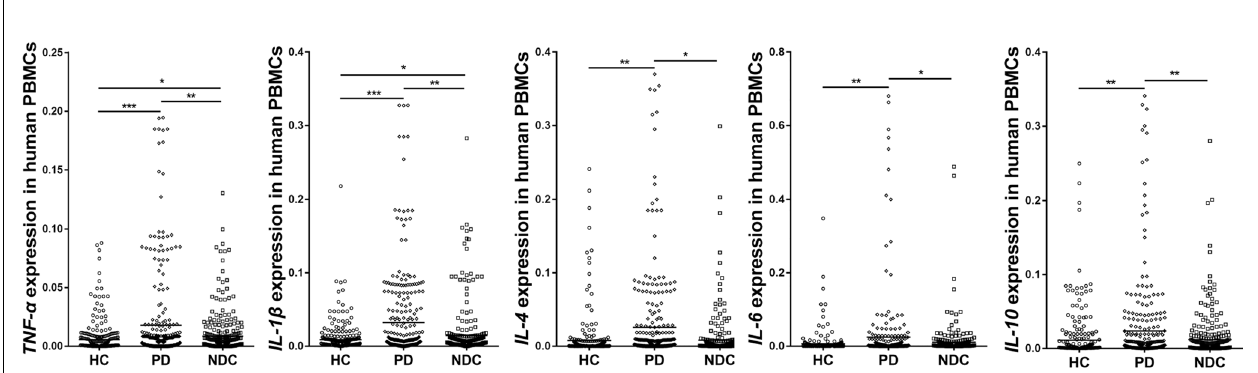
FIGURE 3 | Scatter plots of TNF- α , IL-1 β , IL-4 , IL-6 , and IL-10 relative mRNA expression levels in the PBMCs of HC ( n = 318), PD ( n = 312), and NDC ( n = 332). Significantly higher levels of TNF- α ( p < 0.001), IL-1 β ( p < 0.001), IL-4 ( p < 0.01), IL-6 ( p < 0.05), and IL-10 ( p < 0.01) were seen in PD patients than those in HC.